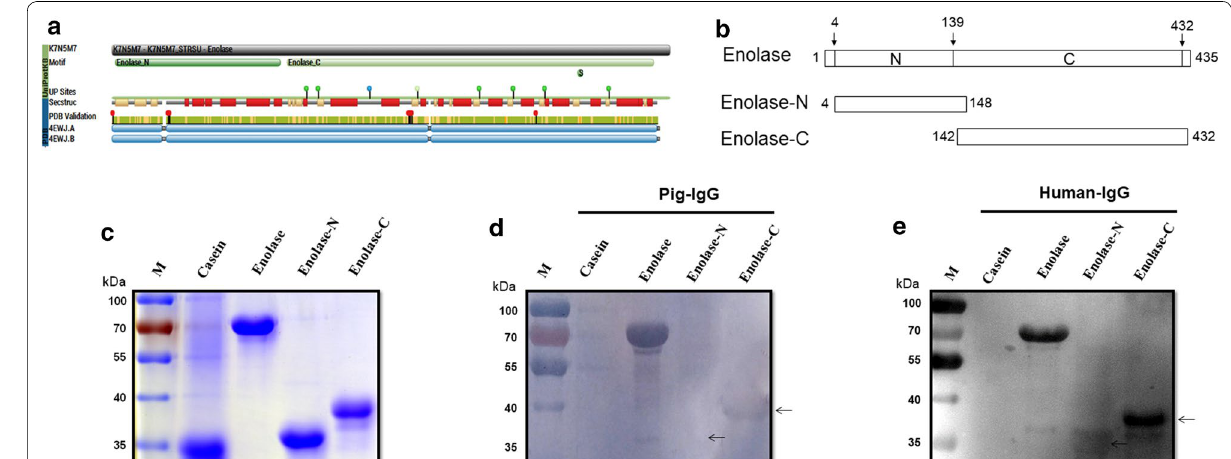
Fig. 4 Interaction of S. suis 2 enolase and its regions with pIgG or hIgG. a The enolase putative domain predicted by the PDB database. b Schematic representation of two recombinant truncations of enolase (Enolase-N and Enolase-C). The truncations of enolase were engineered mainly according to the PDB database. c SDS-PAGE analysis of recombinant enolase, Enolase-N, and Enolase-C. d Far-western blot analysis of enolase and its truncations incubated with pIgG. e Far-western blot analysis of enolase and its truncations incubated with